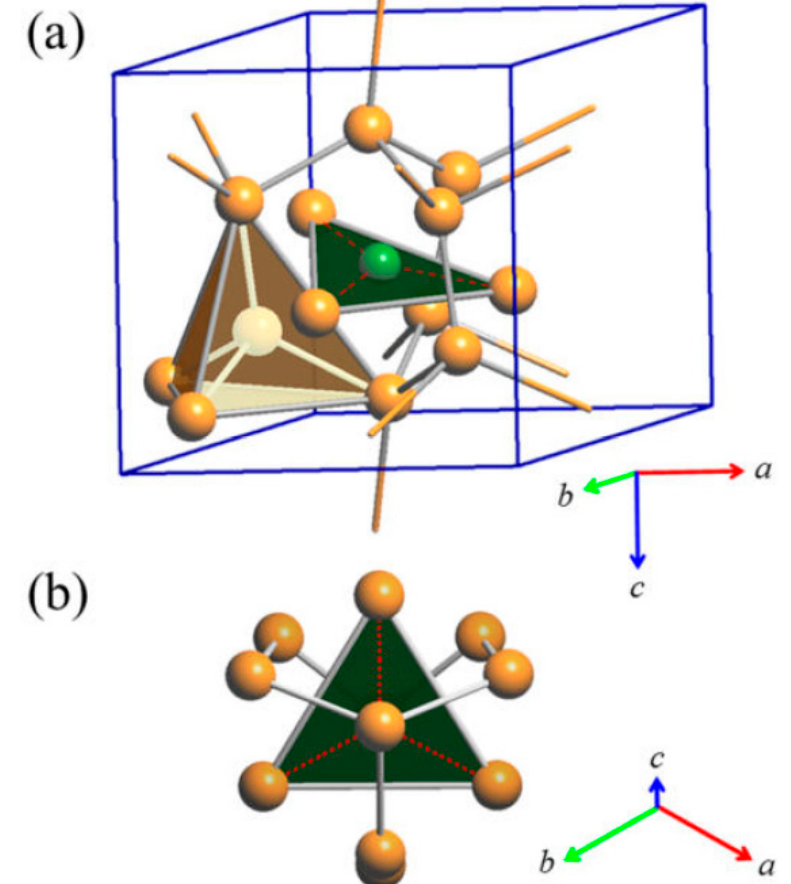
Figure 4. ( a ) Triangular ‘Cu 3 As’ unit (Cu4–Cu1–Cu4) hosting one As atom (6 c ) and placed inside one three-rings cage of the first tridimensional Cu sublattice. One of the tetrahedral units [Cu@Cu 4 ] formed by all the Cu atoms pertaining to the lonsdaleite sublattice (Cu2 and Cu3 atoms) is also shown; ( b ) top view of one triangular ‘Cu 3 As’ unit. Orange and green balls indicate Cu and As atoms,